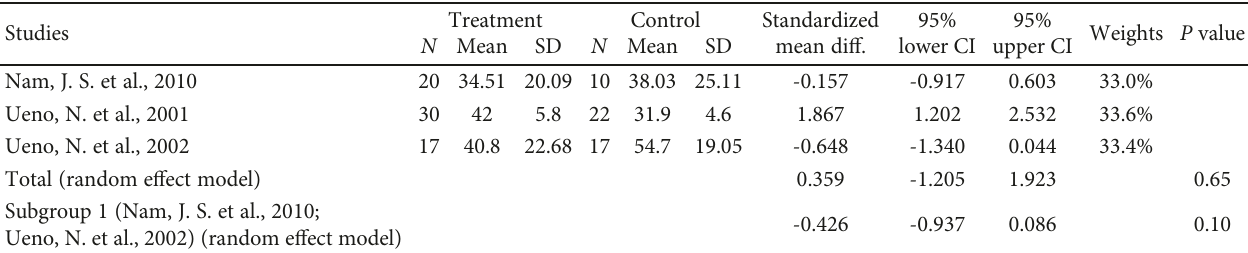
Table 5: The results of meta-analysis for